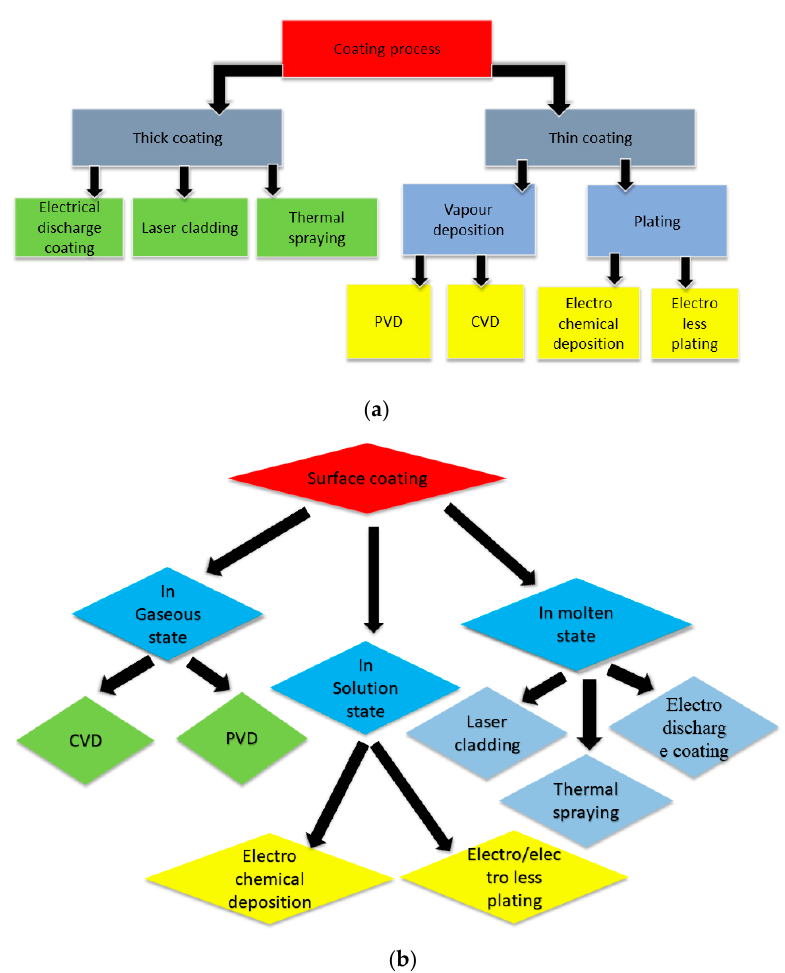
Figure 1. Classification of coating process according to ( a ) state of material in the deposi- tion process and ( b ) coating thickness. and ( b ) coating